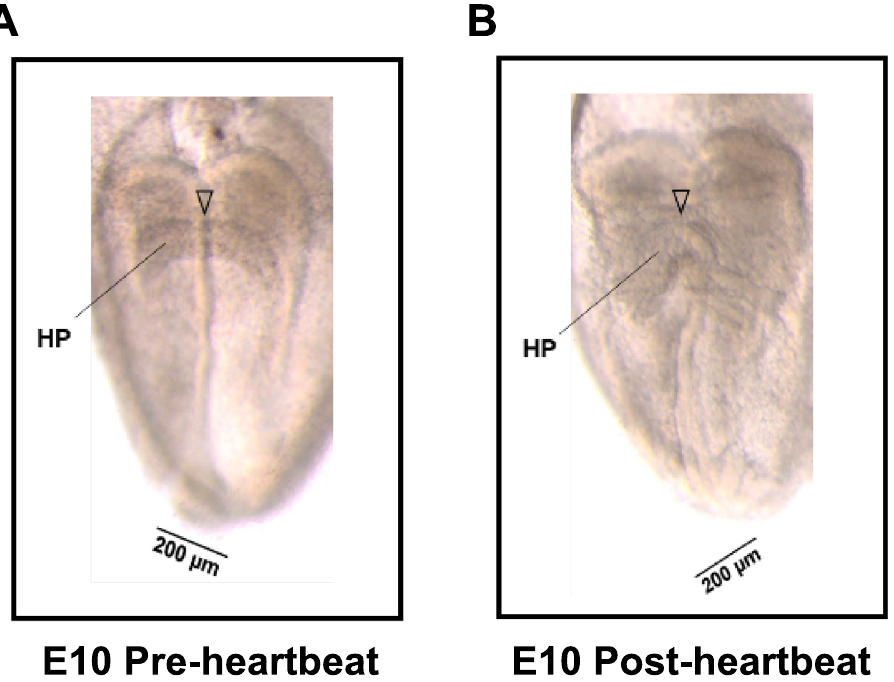
Figure 1. Definitions of rat heart primordia before (pre-) and after (post-) heartbeat initiation. ( A ) Representative image of a rat heart primordium in the embryo at E10 before (pre-) heartbeat initiation. ( B ) Representative image of a rat heart primordium in the embryo at E10 after (post-) heartbeat initiation. The arrowhead indicates the center of the heart primordia. We defined heart primordia showing a “flat” central shape as the pre-heartbeat group and heart primordia showing a “raised” central shape as the post-heartbeat group according to the findings in a previous study 6 . HP: heart